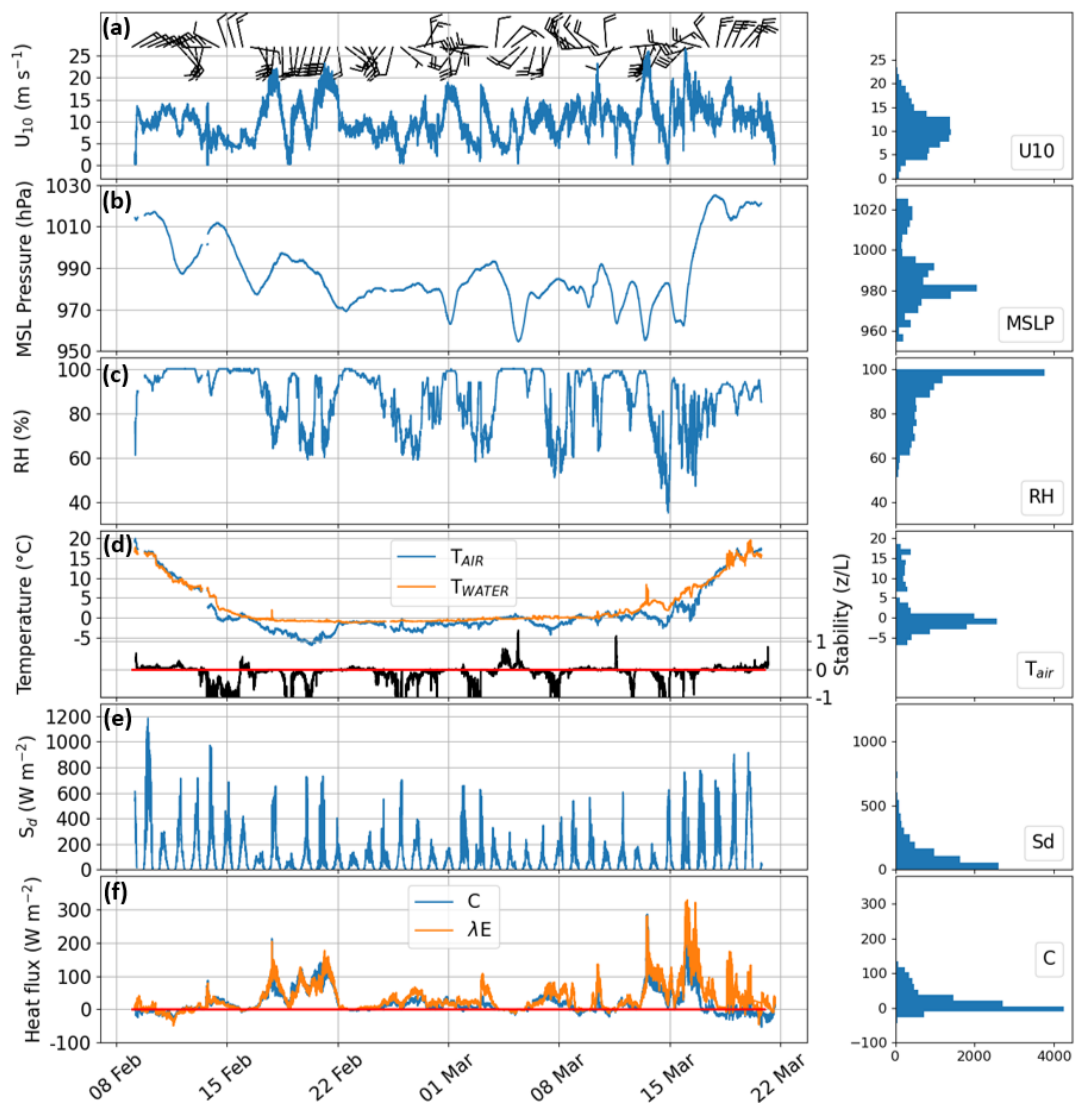
Figure 7. Summary of the meteorological conditions during TAN1802 showing (a) 12-hourly vector-averaged wind barbs for measured wind speed (barbs are in knots; 1 barb is equal to 10knots) together with the wind speed at 10m ( u 10 ), (b) mean sea level pressure (MSLP), (c) relative humidity (RH), (d) air temperature ( T air ), sea surface temperature ( T water ), and the Monin–Obukhov stability parameter ( z/L ) (black line), where z is the height of wind measurement and L is the Obukhov length scale (m), with positive and negative values indicating stable and unstable conditions in the lower atmosphere, respectively, and the zero line in shown in red, (e) shortwave radiation (Sd), and (f) sensible ( C ) and latent ( λE ) heat flux. Small panels on the right show the corresponding histograms for 5min resolution derived from all AWS measurements that were obtained during the voyage. The ship entered the Southern Ocean (region south of 60 ◦ S) on 14 February and left this region on 16 March